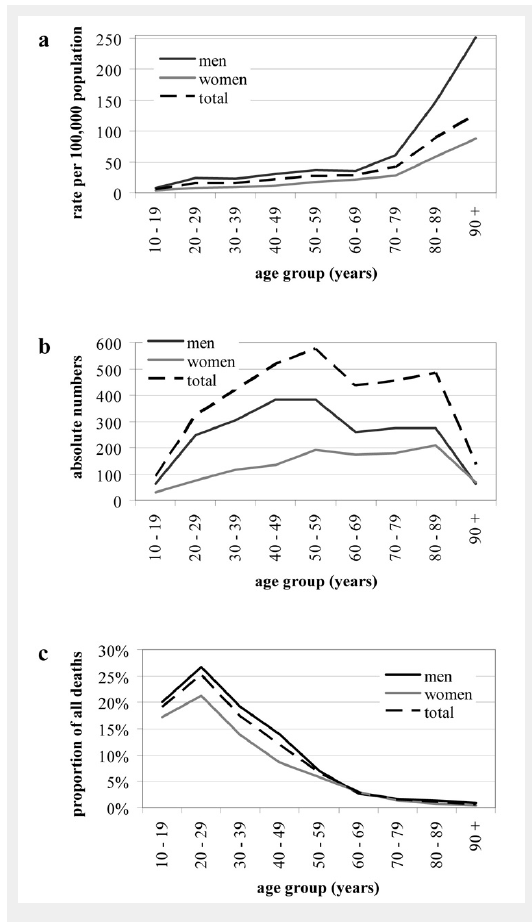
Mean suicide rates per year (a), suicide counts (b) and suicide proportions of all deaths (c) by age group and sex, in the Canton of Zurich,